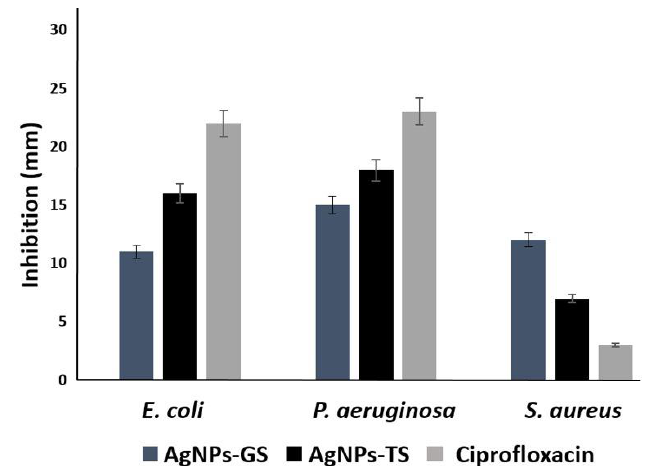
Figure 8. Bar graph showing zone of inhibition produced by biosynthesized AgNPs using super- natants of G. sessile (GS) and T. harzianum (TS) against E. coli , P. aeruginosa and S. aureus .